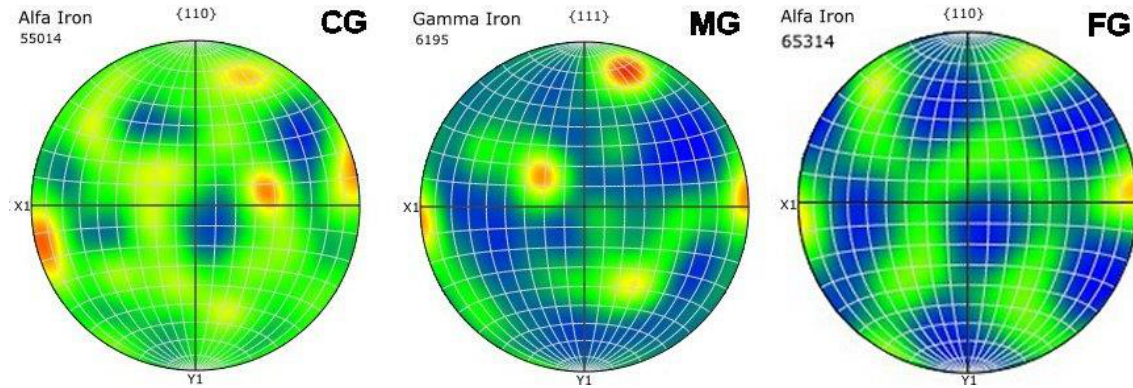
Figure 9. Polar maps of the area represented in Figure 6a comparing the (110) orientation of the alpha phase in the coarse and fine-grained areas with the (111) orientation of the gamma phase in the medium-grained area. A distorted K-S pattern can be observed in the first and second maps. Table 3. EMPA-WDS and SEM-EDX data on the major and minor elements for raster areas and selected phases of the Oglat Sidi Ali meteorite; all data are in wt.%; (—) denotes below detection limit. Detection limits for minor elements in EMPA-WDS analyses are the following (all in wt.%): Ge = 0.049, Cu = 0.011, Si = 0.003, P = 0.003, Cr = 0.007 and S = 0.006; the D.L. for Ge in SEM-EDX raster analyses is 0.05